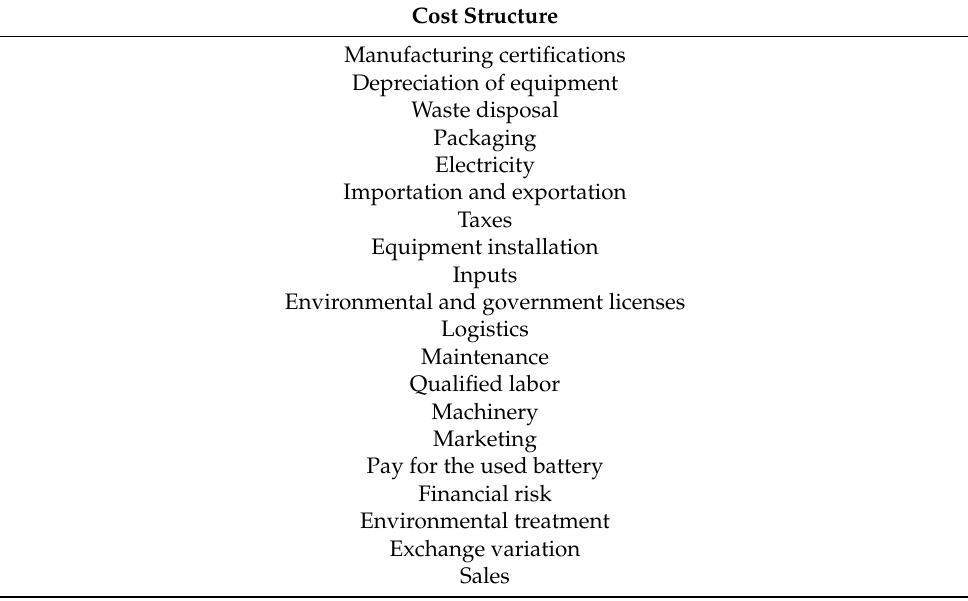
Table 14. Cost structure for LIB recycling business